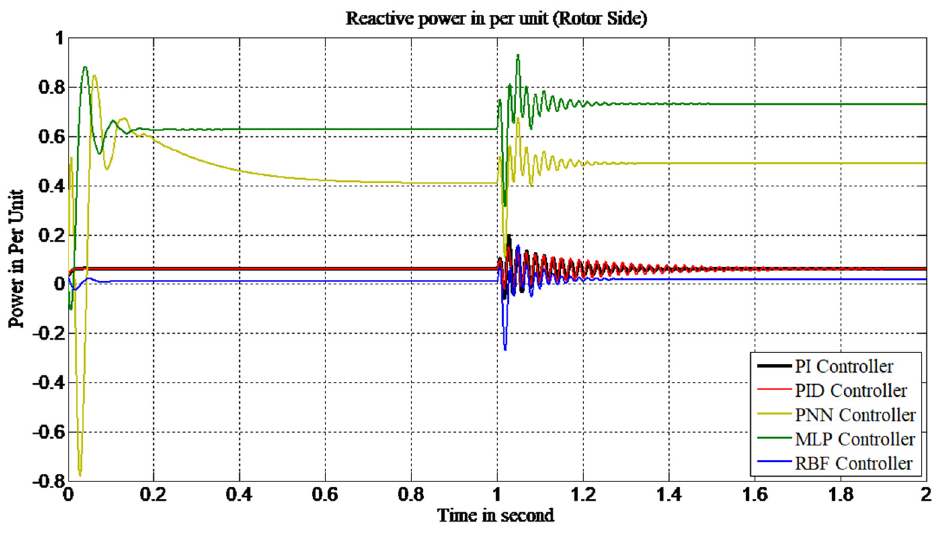
Figure 12. Reactive power at rotor.